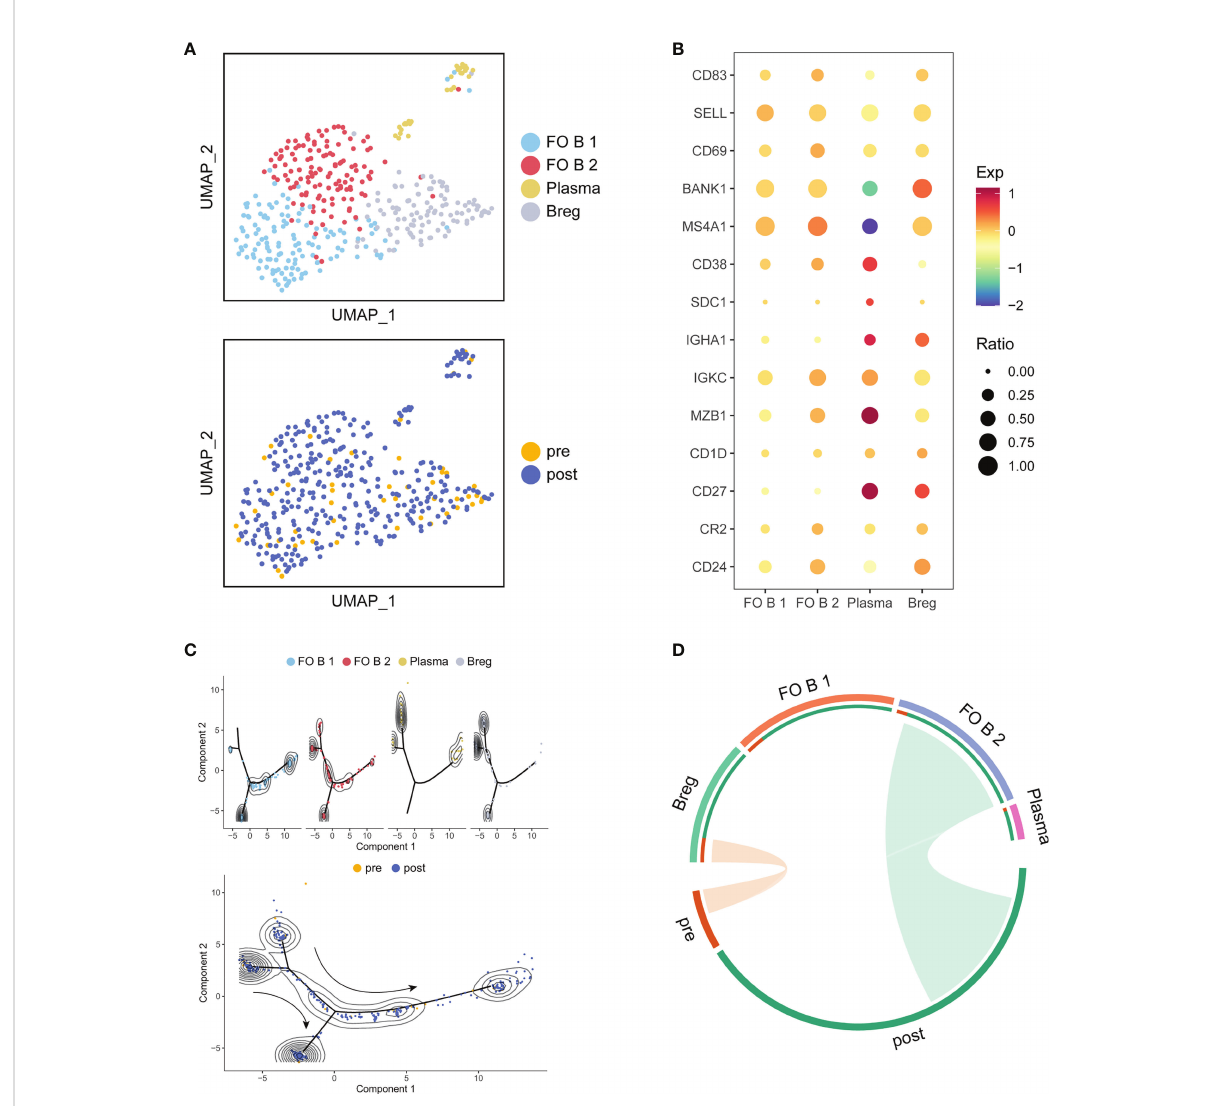
FIGURE 6 Detailed characterization of B cells and their association with treatment. (A) UMAP of B cells, colored by cell type and sample. (B) Bubble plot of selected B cells function-associated genes in each cell cluster. (C) Pseudotime analysis of B cells inferred by Monocle2. Each point corresponds to an individual cell colored by cluster (above) or by treatment (down). The density curves represent the distribution of each cluster. (D) The association between subtypes and treatment in B cells. The area of the ties represents the relative